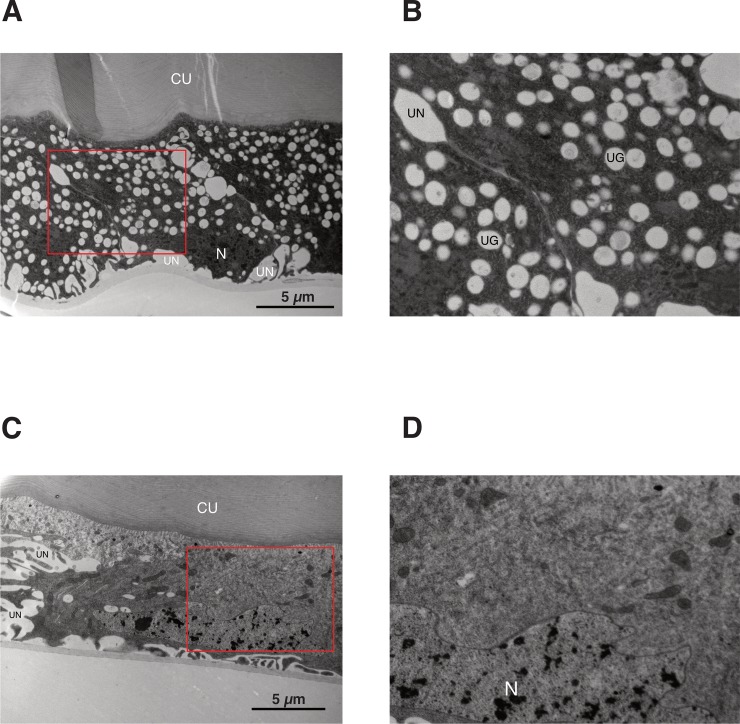
Transmission electron microscopy of the epidermis of wild-type and Samia ricini biogenesis of lysosome-related organelles complex 1, subunit 2 knockout (SrBLOS2KO) individuals.Low- (A) and high-magnification (B) micrographs of the epidermis of a fifth-instar day 4 wild-type larva. Low- (C) and high-magnification (D) micrographs of the epidermis of a fifth-instar day 4 SrBLOS2KO larva. Red squares in A and C indicate the regions enlarged in B and D, respectively. N, nucleus; CU, cuticle; UG, urate granules; UN, unknown vacuole-like organelles.